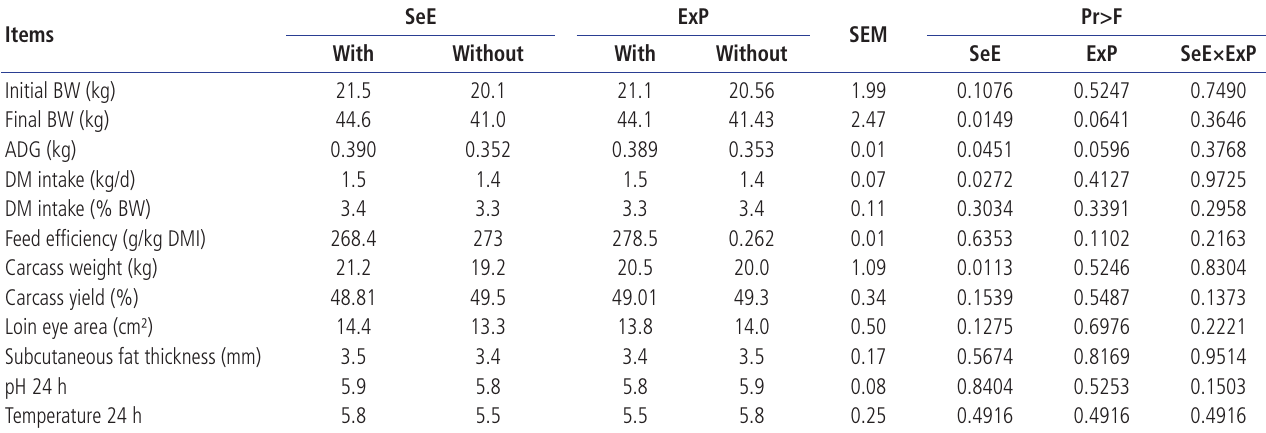
Table 2. Performance and carcass data of Dorper×Santa Ines lambs receiving a high-concentrate diet with different antioxidant additives